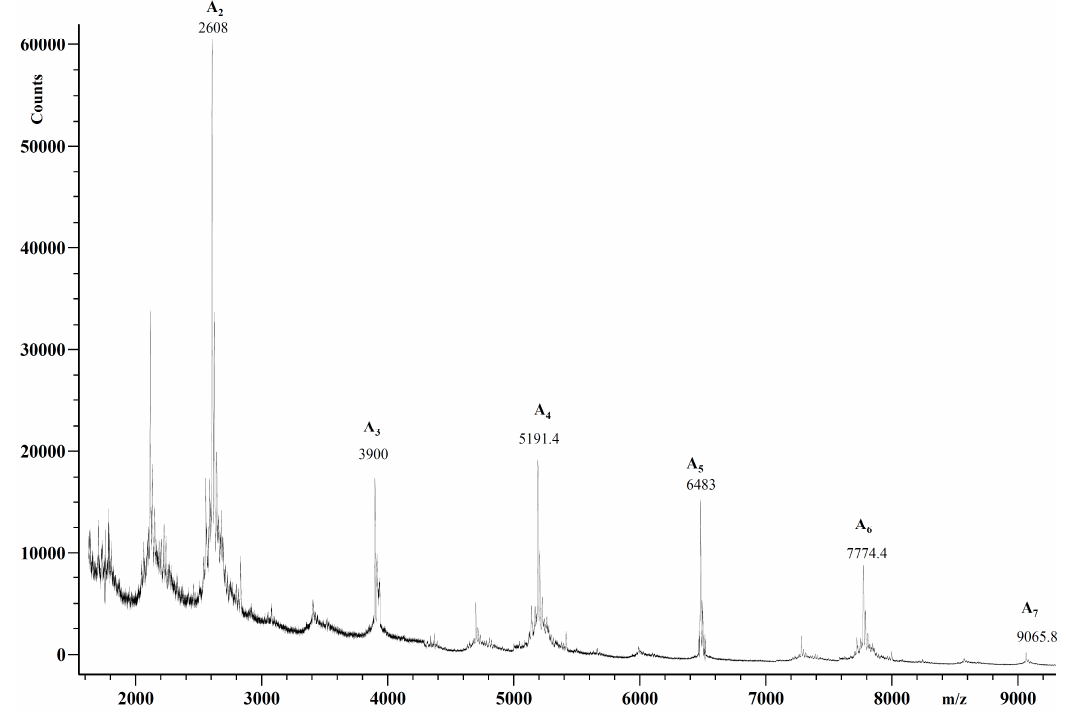
Figure 15. MALDI-TOF mass spectrum of poly-4,6-MOEG-9-TM- BF3k .